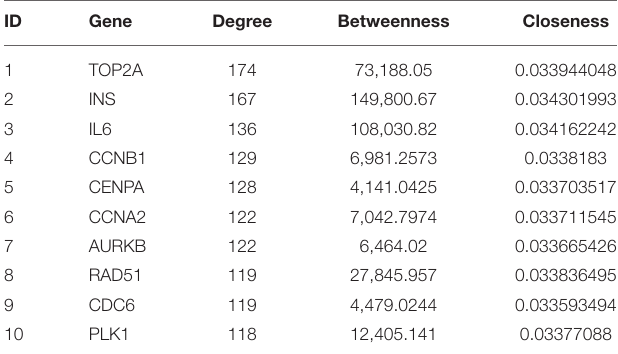
TABLE 1 | The 10 most important DEGs identified from topology analysis of the PPI